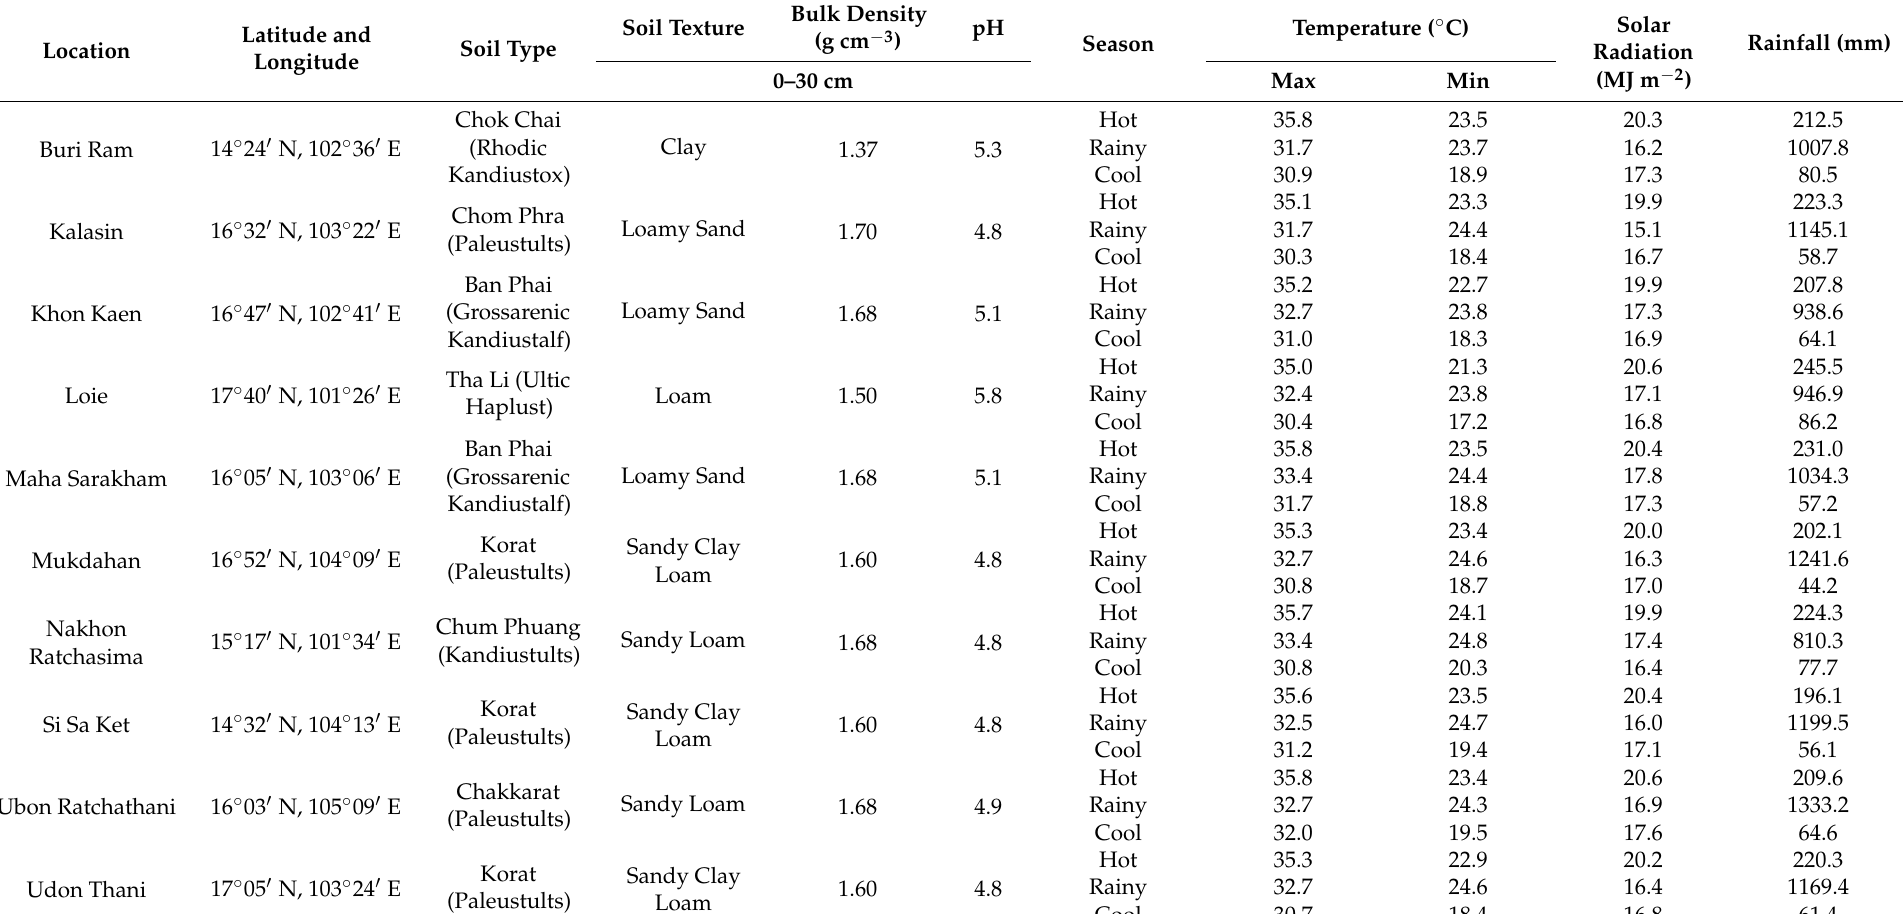
Table 1. Geographical coordinate, soil type, and average over 30 years (1988–2018) for daily maximum air temperature (Max), minimum air temperature (Min), daily solar radiation, and total rainfall during the hot season (mid-February to mid-May), rainy season (mid-May to mid-October), and cool season (mid-October to mid-February) for the ten selected locations in